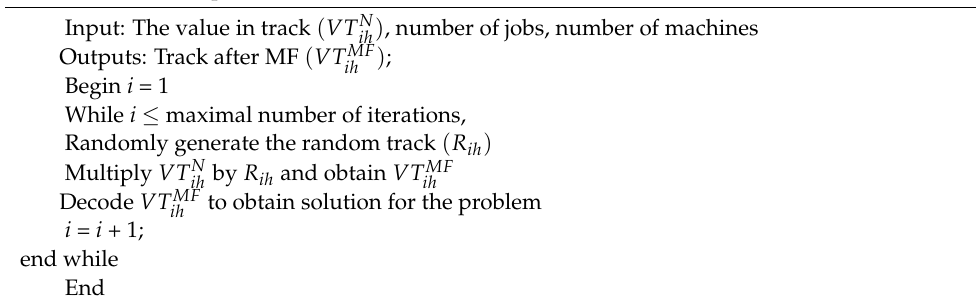
Algorithm 6. Multiplier